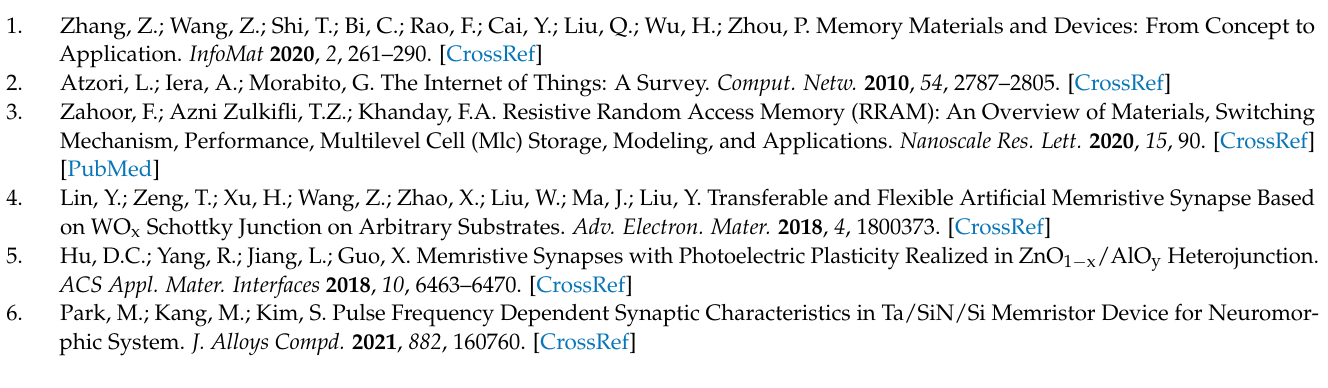
Figure 7. EPSC characteristics in ( a ) positive voltage and ( b ) negative voltage.